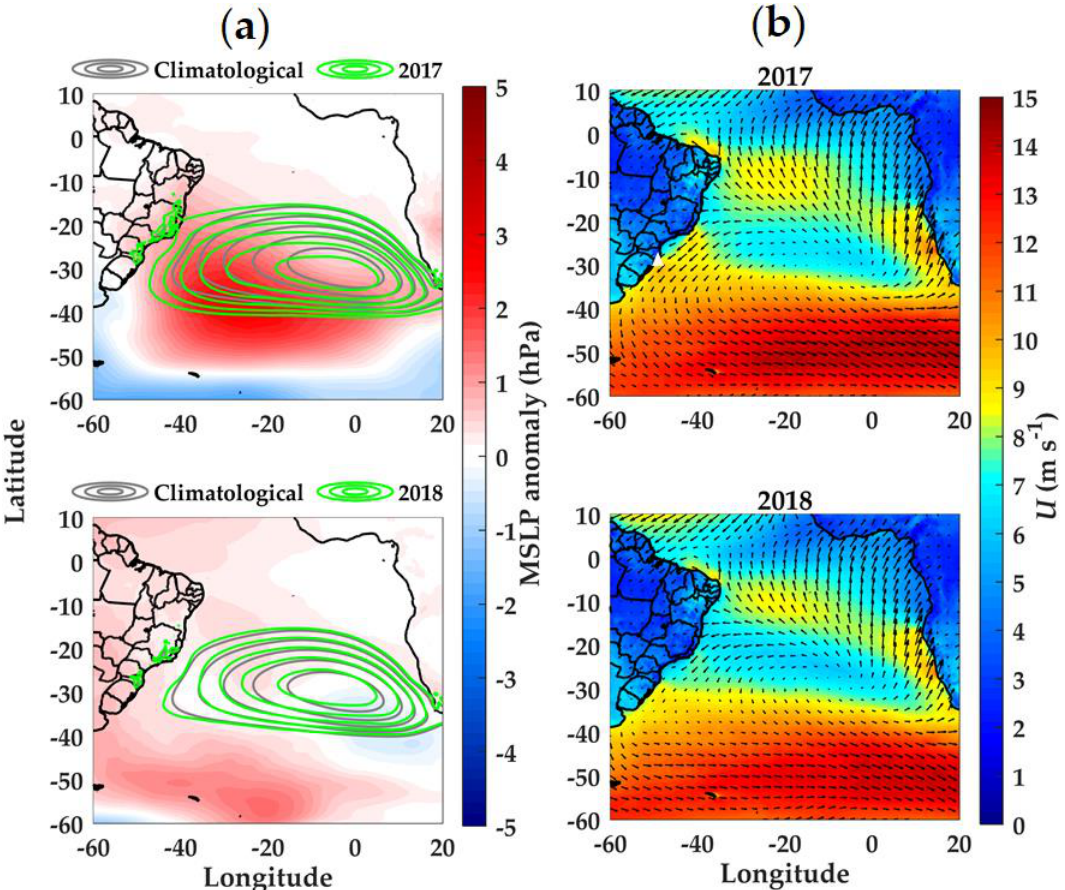
Figure 6. ( a ) Climatological (1979–2020) and yearly mean sea level pressure fields (MSLP). The South Atlantic subtropical high (SASH) climatological position is defined by gray contours, while the yearly positions for 2017 (upper panel) and 2018 (lower panel) have green contours. Isobaric contours have 1 hPa increments. The contour interval is 1017–1022 hPa for 2017 and 1017–1021 hPa for 2018 and the climatological field. ( b ) Wind speed magnitude (colors) and wind vectors for the height of z = 100 m above the ground for the years of 2017 (upper panel) and 2018 (lower panel). Both MSLP and the wind speed fields are derived from ERA5 Reanalysis product [52]. A white triangle marks the position of the BOOA.